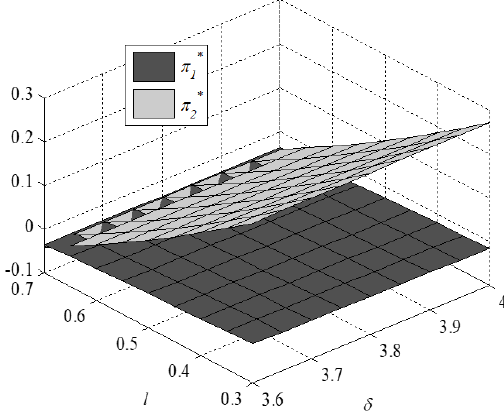
Figure 3. Changes in market demand.